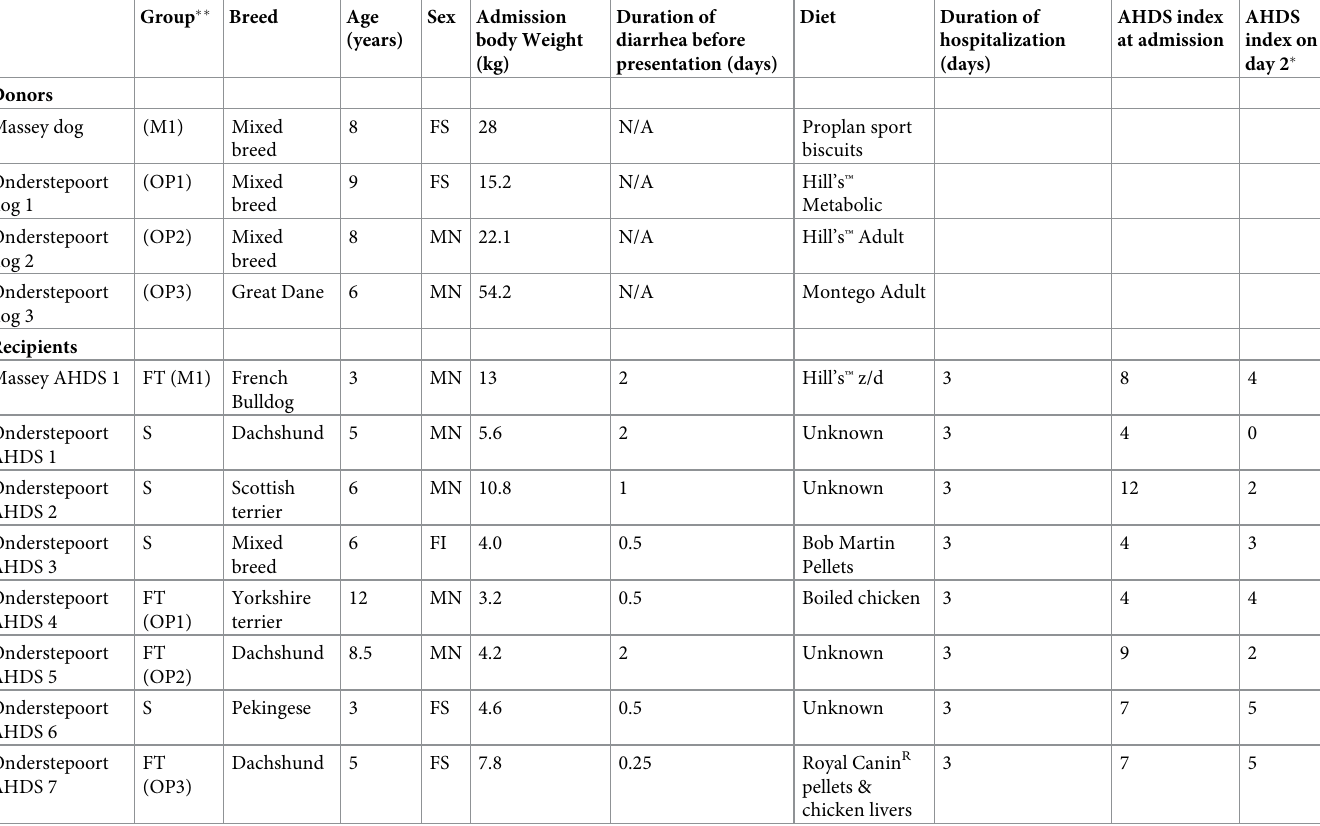
Table 1. Demographic information of donors and AHDS dogs. Group ��